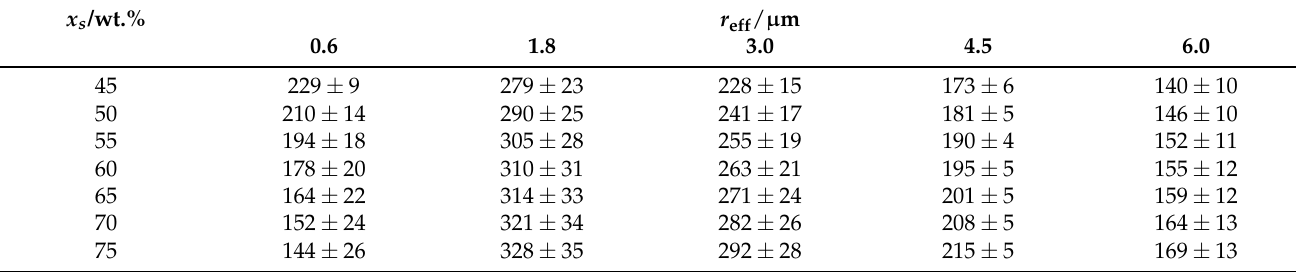
Table 3. Mean mass extinction coefficients at 10.8µm ( k 10.8 ) and their standard deviations for different volcanic ashes (from [23]) given in m 2 kg − 1 . Subsets of different effective radii r eff and silica contents x s are considered. x s